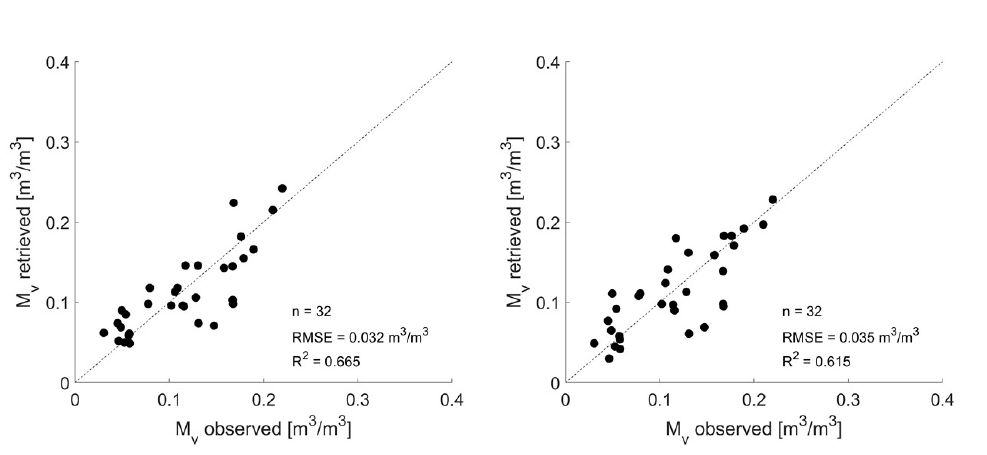
Figure 11. Simulated field-average soil moisture values based on effective roughness modeling for the Oh model ( left ) and AIEM ( right ) against observed field-average soil moisture values, using multi-polarized backscatter